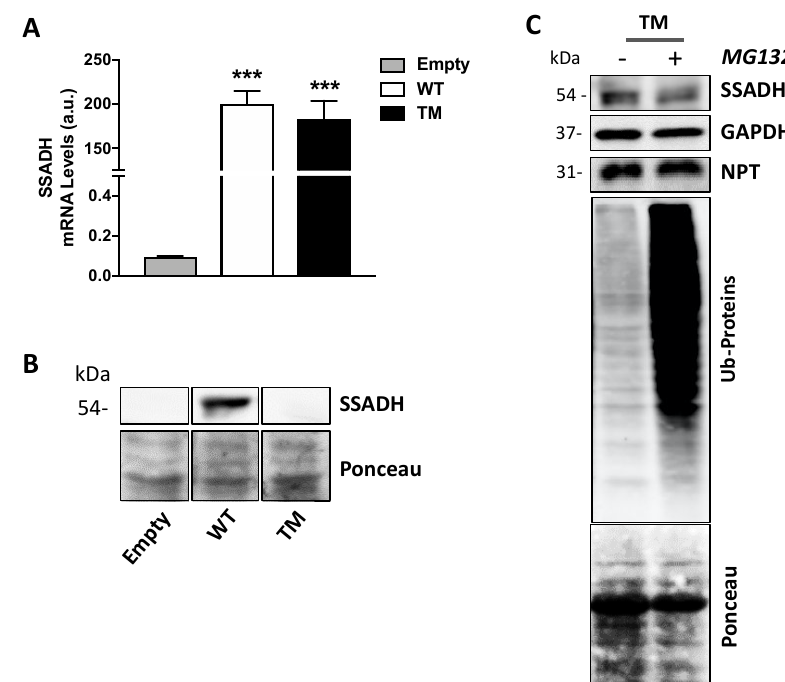
Figure 2. Triple mutant succinate semialdehyde dehydrogenase (TM SSADH) undergoes degradation in U87 cells. U87 cells were transiently transfected for 24 h. ( A ) RT-qPCR analysis of mRNA levels of ALDH5A1 gene, normalized for both β-Actin and NPT mRNAs. Data are shown as mean ± SD. n = 3, *** p < 0.001; ( B ) SSADH protein levels in the precipitated protein fraction. Ponceau staining was used as loading control. A total of 20 µg of total protein extract was loaded on each lane; ( C ) cells were treated with 10 µM MG132 proteasome inhibitor, during transfection, and TM SSADH and ubiquitinated proteins were assessed by Western blot analysis. Glyceraldehyde 3 phosphate dehydrogenase (GAPDH) was used as loading control, NPT for transfection efficiency, Ponceau protein staining as loading control for ubiquitinated proteins. Representative Western blot analyses are shown.